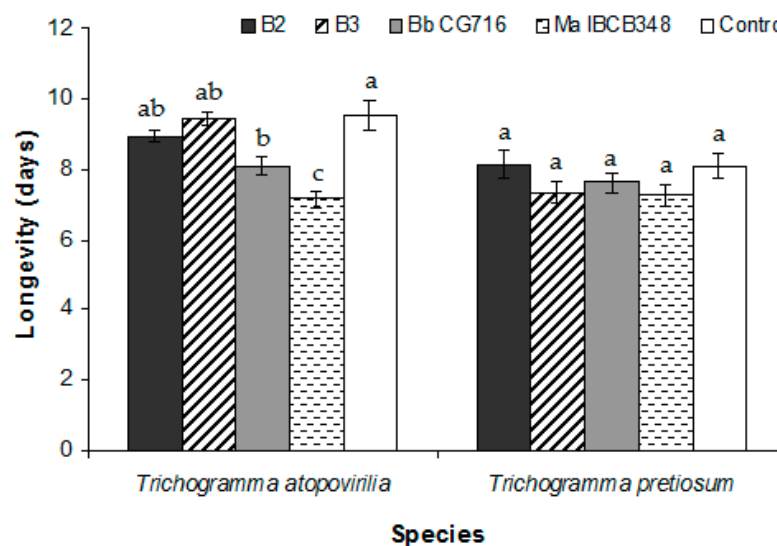
Figure 4. Average longevity of Trichogramma atopovirilia and Trichogramma pretiosum individuals emerged from Duponchelia fovealis eggs sprayed with Beauveria bassiana strains (B2 and B3) and commercial bioinsecticides (Bb CG716 and Ma IBCB348) pre-parasitism. Error bars are standard errors (n = 15). Small letters over the bars indicate significant differences among treatments according to the Tukey HSD test ( p -value < 0.05).